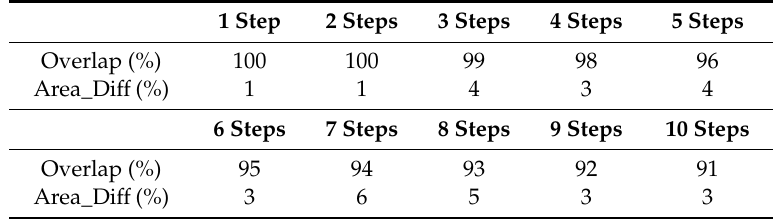
Table 5. Comparison of predicted crack shape from ARIMA against ground truth.